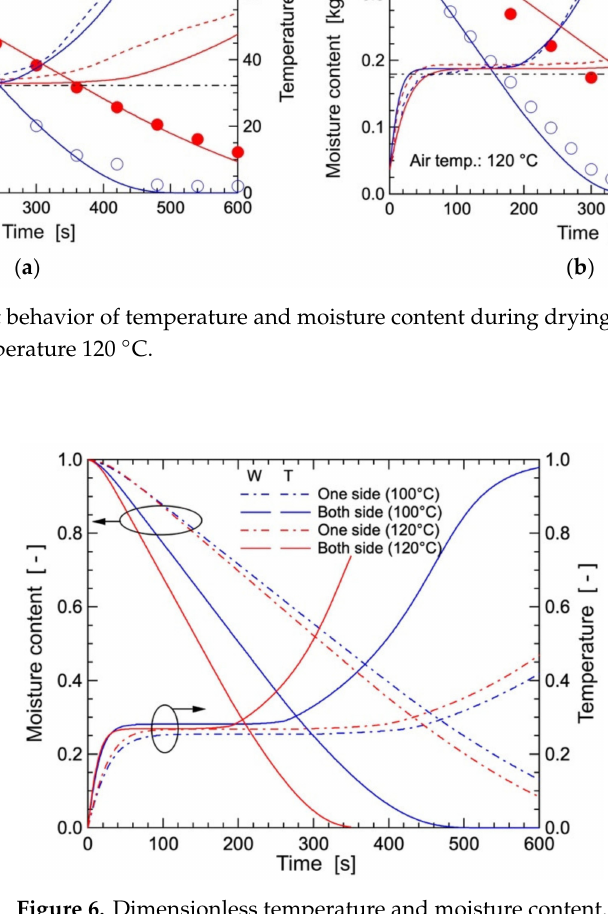
Figure 6. Dimensionless temperature and moisture